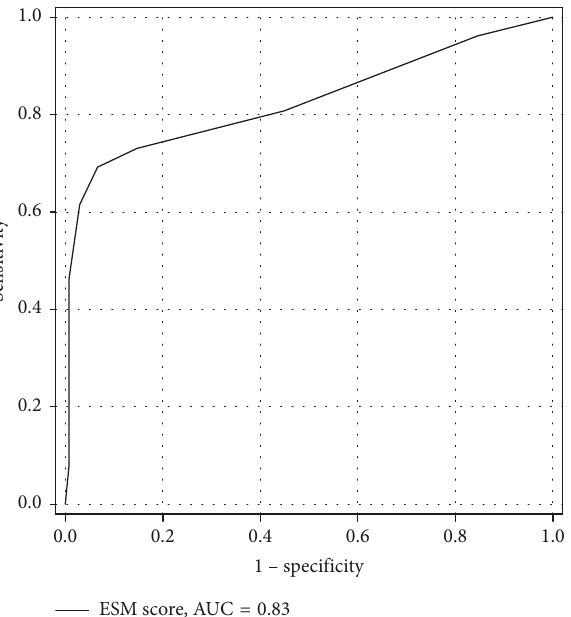
Figure 3: AUC of ESM score to predict mortality in the Validation group. ESM: emergency surgery mortality; AUC: area under the receiver operating characteristic